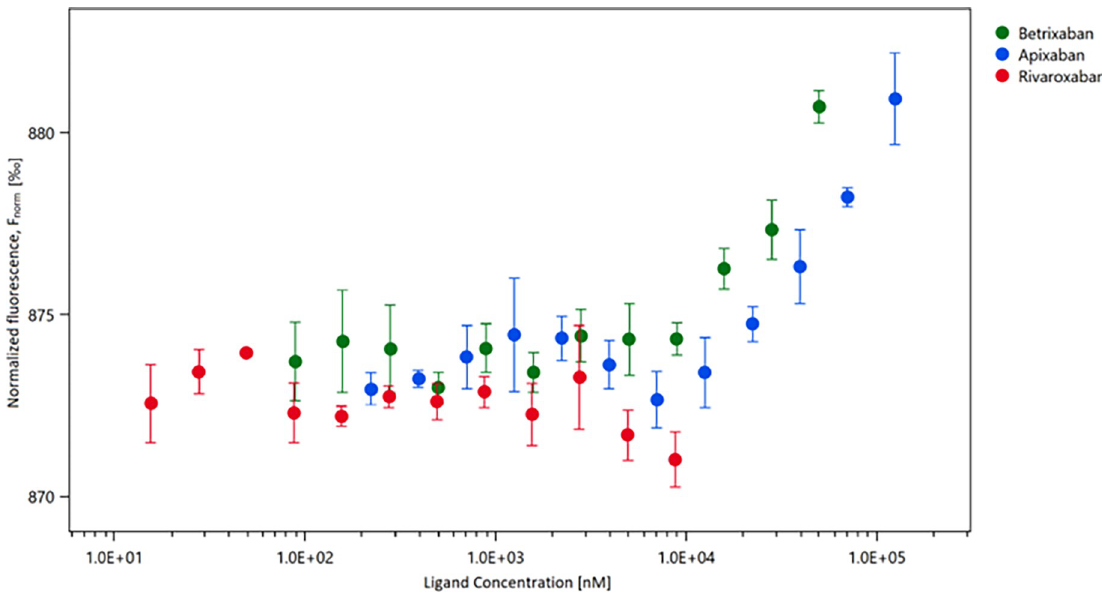
Fig 1. Results of the change in normalized fluorescence depending on the concentration of the ligand.